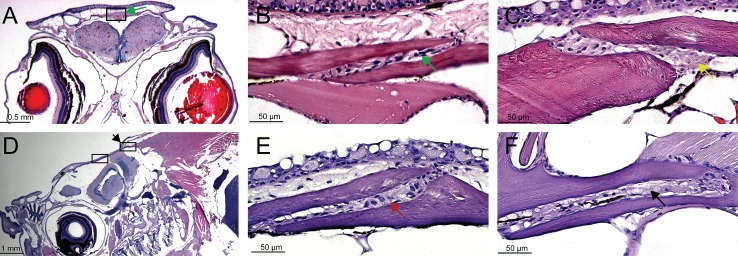
Histological examination of cranial sutures in adult zebrafish.H&E stained transverse sections (A-C) and sagittal sections (D-E) of skulls. (A) The interfrontal suture (boxed) and presented in (B) higher magnification; green arrows indicate the interfrontal suture between overlapping frontal bones. (C) The sagittal suture (yellow arrow) observed between two parietal bones. (D) The sagittal plane of sectioning revealed the coronal (left box) and lambdoid sutures (right box, black arrow). (E) The posterior frontal bone overlapping the anterior portion of the parietal bone, with the coronal suture formed between them (red arrow). (F) The lambdoid suture (black arrow) separates the parietal (upper plate) and the supraoccipital bone (lower plate).